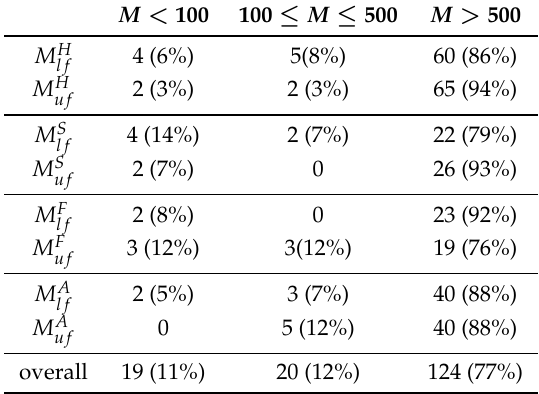
Table 3. An overview of the scores obtained by the proposed pipeline on the subjects in the CK+ dataset. M < 100 100 ≤ M ≤